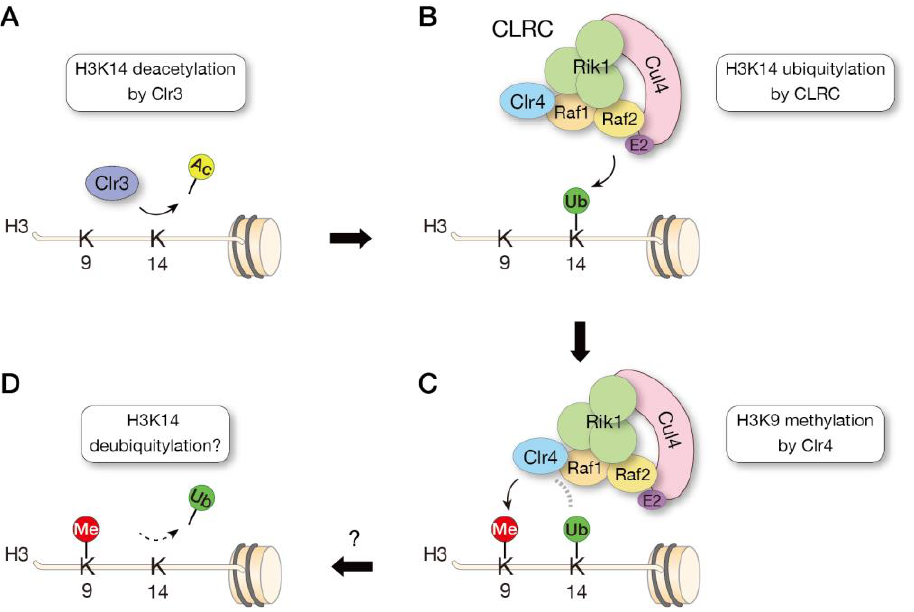
Figure 3. Model of crosstalk between histone methylation and ubiquitylation. The fission yeast histone methyltransferase Clr4 forms a CLRC complex with factors involved in ubiquitylation. Heterochromatin formation is thought to occur in the following steps: deacetylation of H3K14 by Clr3 ( A ), ubiquitylation of H3K14 by the CLRC complex (H3K14ub) ( B ), and methylation of H3K9 by Clr4 ( C ). Clr4 activity is promoted by the presence of H3K14ub. H3K14ub is thought